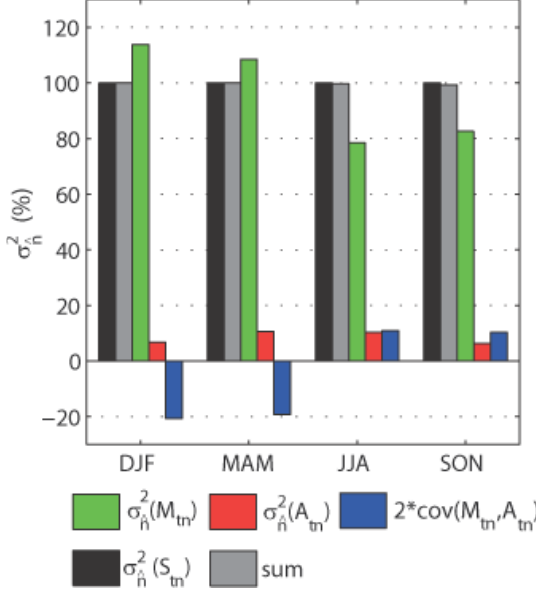
(A tn ) and (M tn ) , σ 2 b n b n